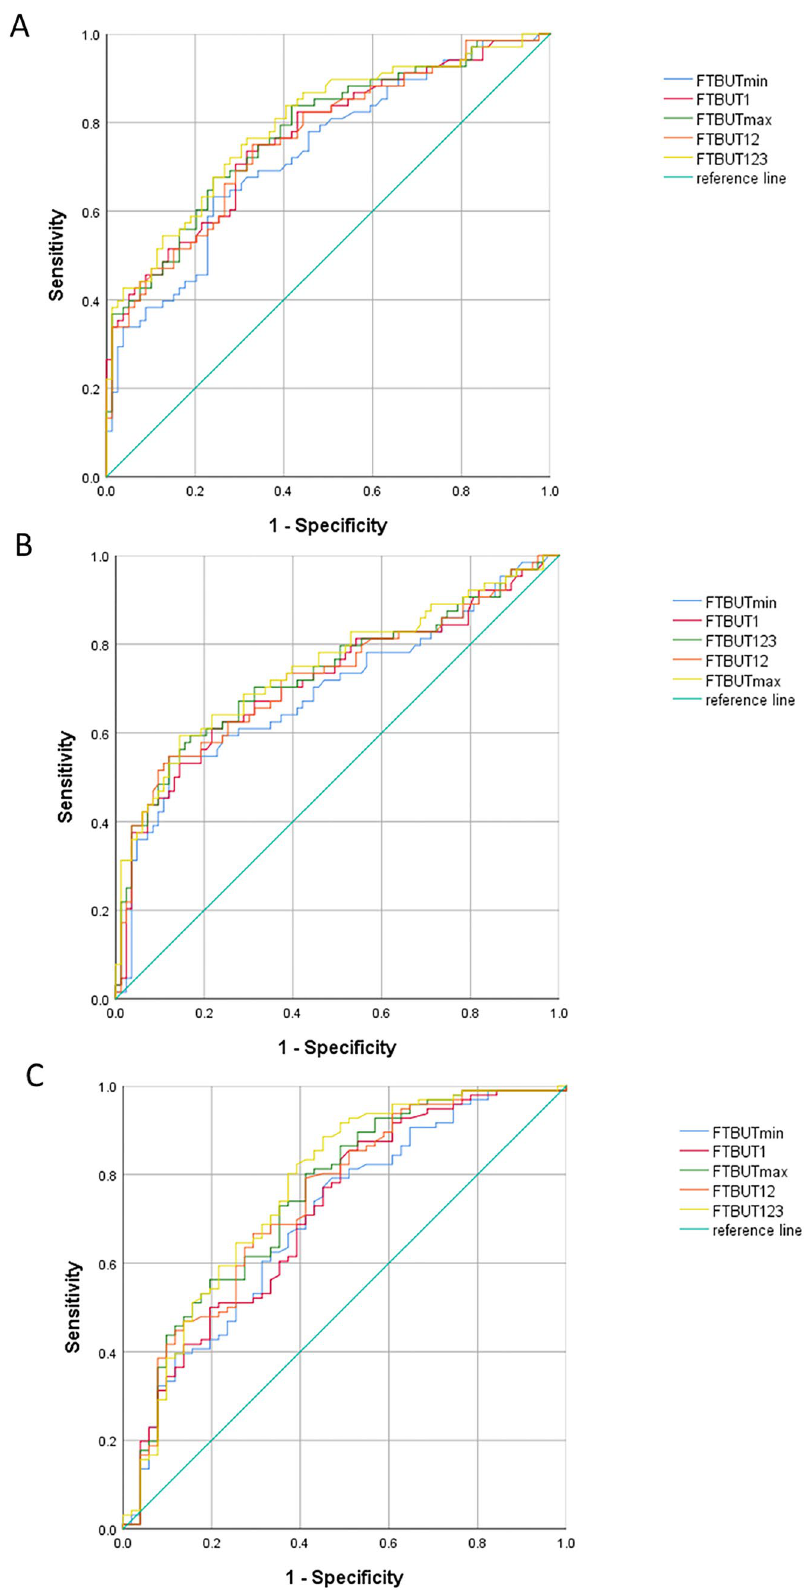
Figure 2. ROC parameters of FTBUTmax, FTBUTmin, FTBUT1, FTBUT12 and FTBUT123 dividing by Schirmer I test ( A ), OSDI scores (B) or CFS ( C )